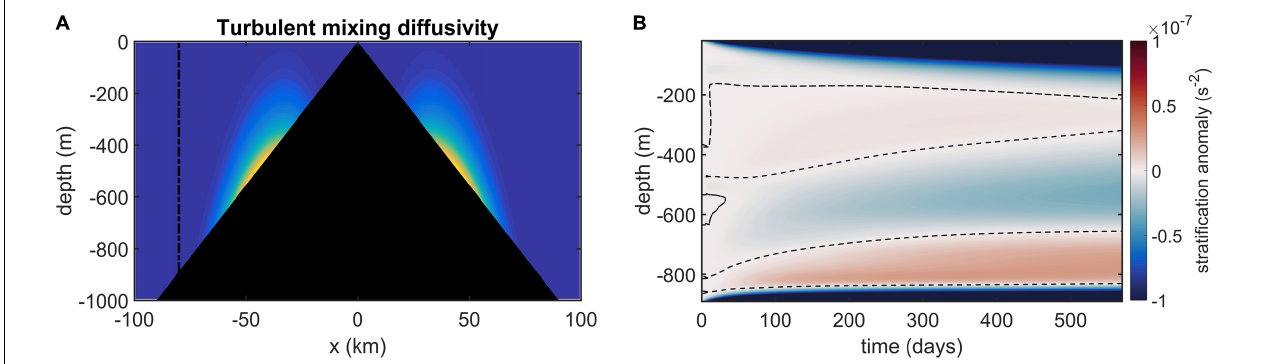
FIGURE 12 | (A) Spatial distributions of the turbulent diffusivity applied in the model experiment Exp2. (B) The evolution of stratification anomaly (relative to the initial stratification) in the column is indicated with a dashed line in panel (A) . The thin dashed lines in panel (B) indicate the value of zero.